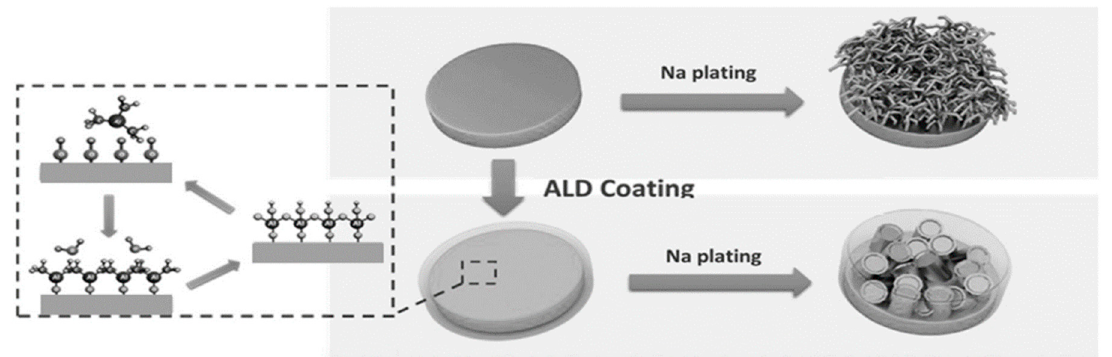
Figure 9. Schematic representation of Na anode protection strategy employing atomic layer deposi- tion. Reproduced with permission [156]. Copyright 2017, Wiley.